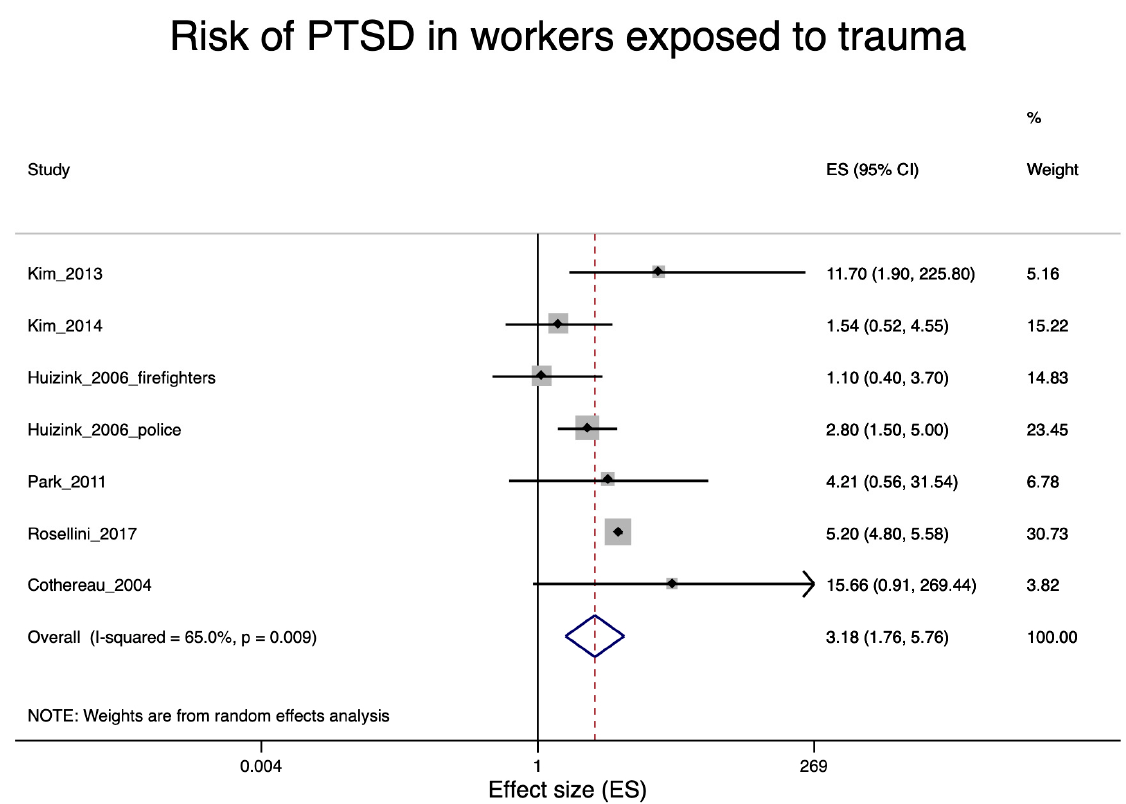
Figure 5. Forest plot of workers exposed to occupational trauma and the estimates of e ff ect size (ES) for post-traumatic stress disorder (PTSD). Note: unadjusted prevalence ratio (PR) for Park et al., 2011 [45] and Cothereau et al., 2004 [56]; Cothereau et al., 2004 [56] was included by adding a 0.5 case to all categories.